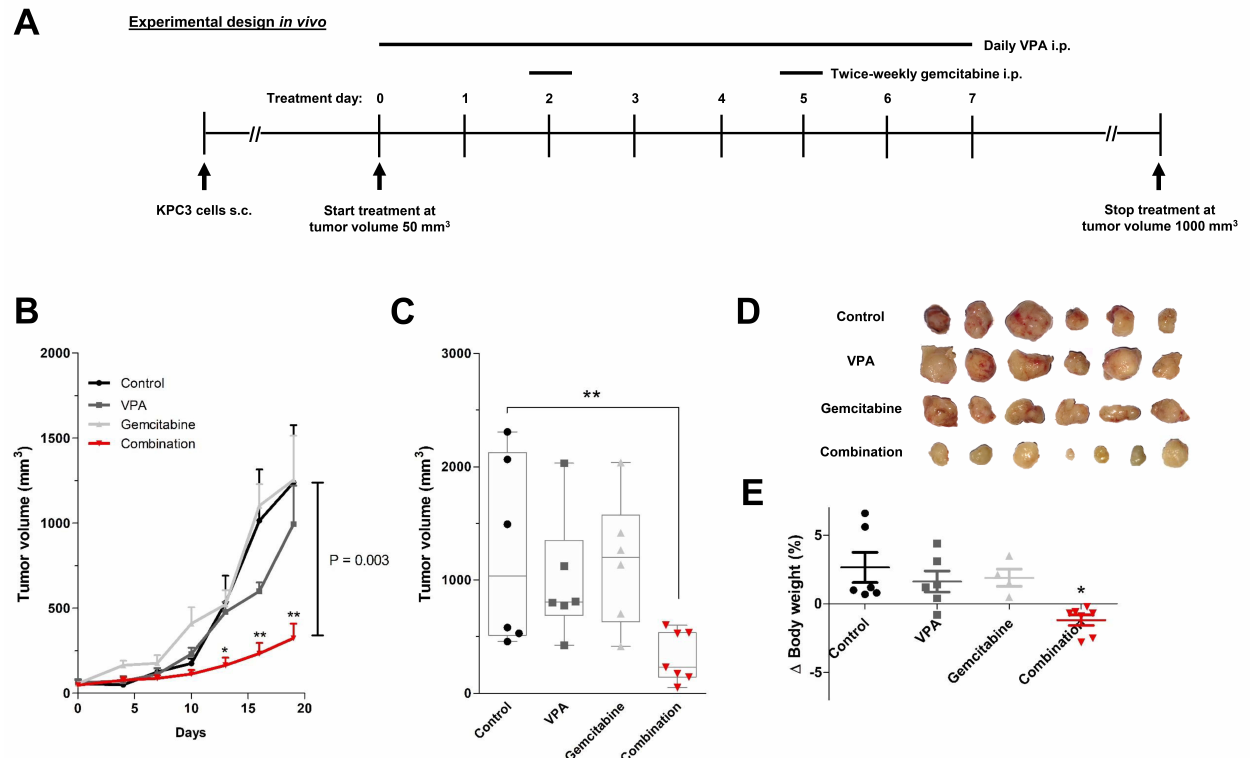
Figure 5. In vivo treatment effects of gemcitabine combined with VPA in immune competent mice. ( A ) Experimental design for in vivo experiments. KPC3 mouse pancreatic cancer cells (1 × 10 5 /100 µ L PBS/0.1% BSA) were subcutaneously injected in C57BL/6 mice. Treatment was started when tumor volumes reached 50 mm 3 . Groups of mice received daily an intraperitoneal (i.p.) injection of VPA (500 mg/kg), two times a week (at day 2 and 5) an i.p. injection of gemcitabine (50 mg/kg), or the combination of VPA plus gemcitabine. Mice in the control group received daily an i.p. injection of 100 µ L distilled water. ( B ) Time course of change in tumor volume. ( C ) After 21 days of treatment, mice were sacrificed and tumor volumes were measured. ( D ) Tumor images after 21 days of treatment. ( E ) Body weight difference from start until end of treatment. Values represent mean ± SEM. * p < 0.05 and ** p < 0.01 versus